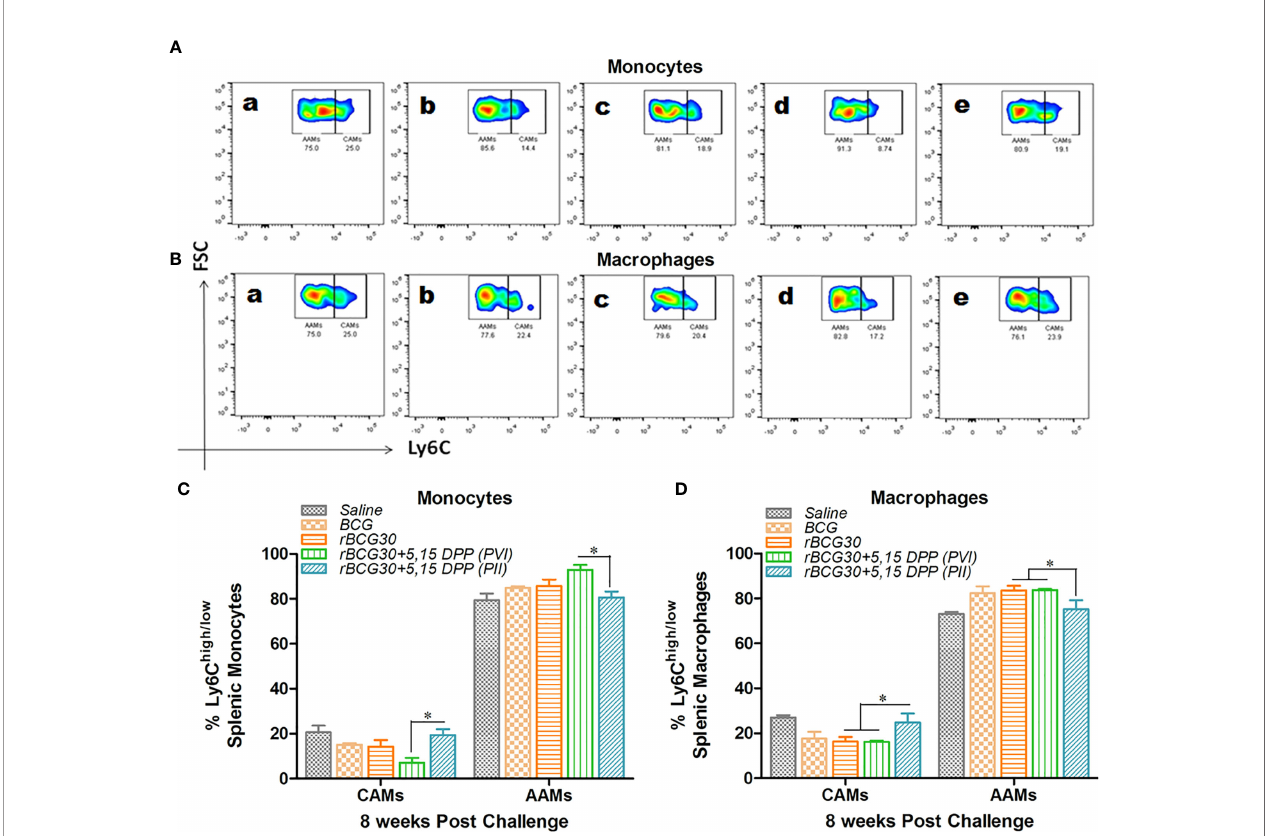
FIGURE 3 | Comparative abundance of classical (CAMs) and alternative (AAMs) splenic monocytes/macrophages at week 8 post-challenge. Representative FACS micrographs and bar graphs in the fi gure represents the percent frequency of Ly6C high CAMs and Ly6C low AAMs among (A, C) CD11b + F4/80 - SSC low monocytes and (B, D) CD11b + F4/80 + SSC low macrophages isolated from the spleen of mice (n=4-5) belonging to various groups and pro fi led using fl ow cytometry. The various groups included in the study and depicted in the FACS micrographs were: (a) Saline, (b) BCG, (c) rBCG30, (d) rBCG30+5,15-DPP (PVI), and (e) rBCG30+5,15-DPP (PII). The results depicted in the fi gure are representative of two independent experiments and are presented as means ± SEM of one of the two experiments with similar observations. The signi fi cance testing of differences between various groups was performed employing Two-way ANOVA followed by Bonferroni ’ s multiple comparison post-test. The p values, <0.05(*), <0.01(**), <0.001(***) were considered as signi fi cant for analysis and interpretation of the